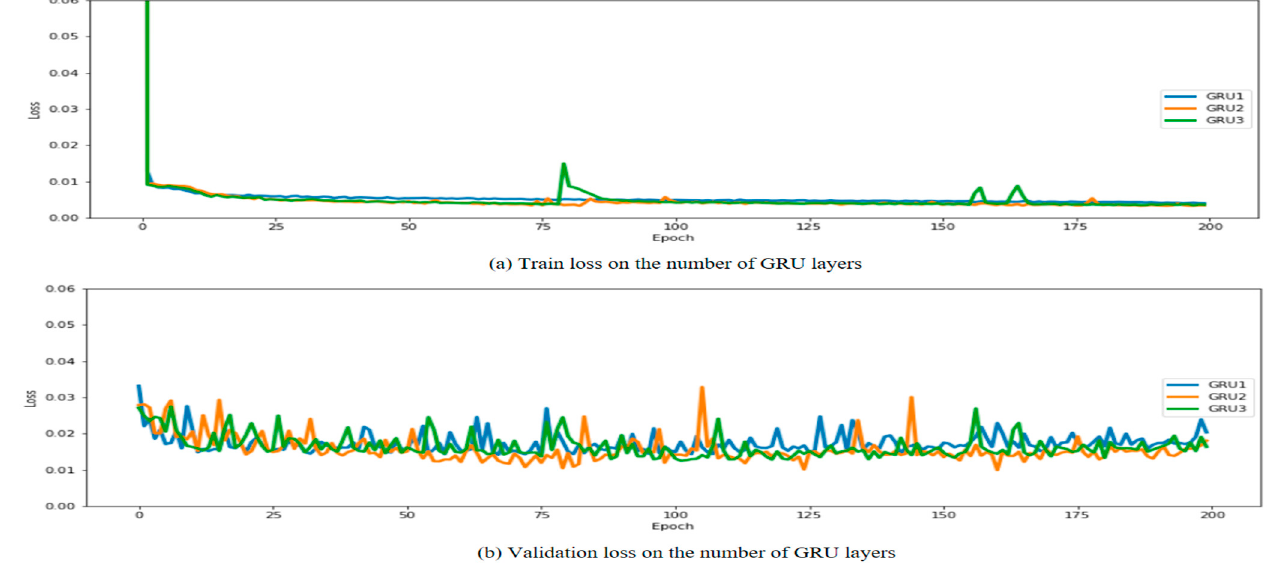
Figure 10. Train and validation loss values according to the number of GRU layers. ( a ) Train loss on the number of GRU layers; ( b ) validation loss on the number of GRU layers.